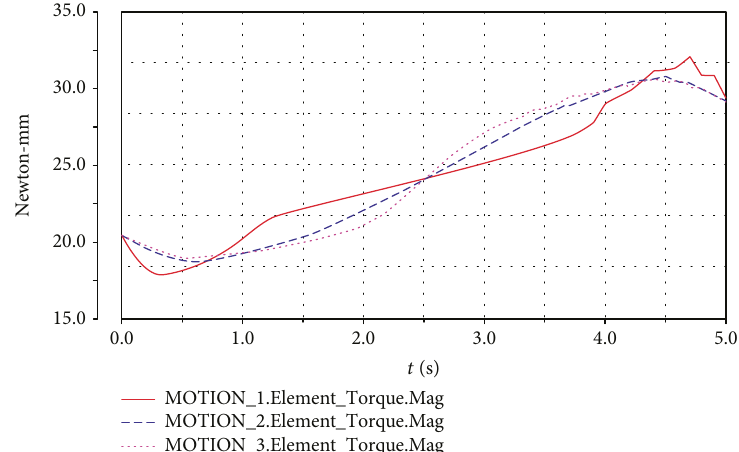
Figure 16: Torque for the upper platform moving downward. MOTION_5: modi fi ed constant velocity function; MOTION_6: modi fi ed sine function; MOTION_7: modi fi ed trapezoidal function.